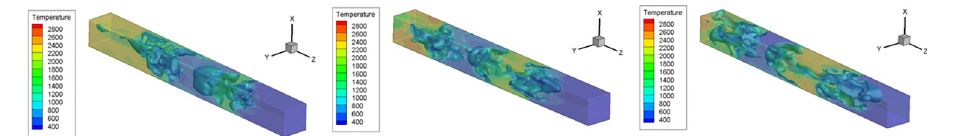
Fig 24. Temperature isosurface at different gas concentrations at 90 ms(5%; 9.5%; 16%).